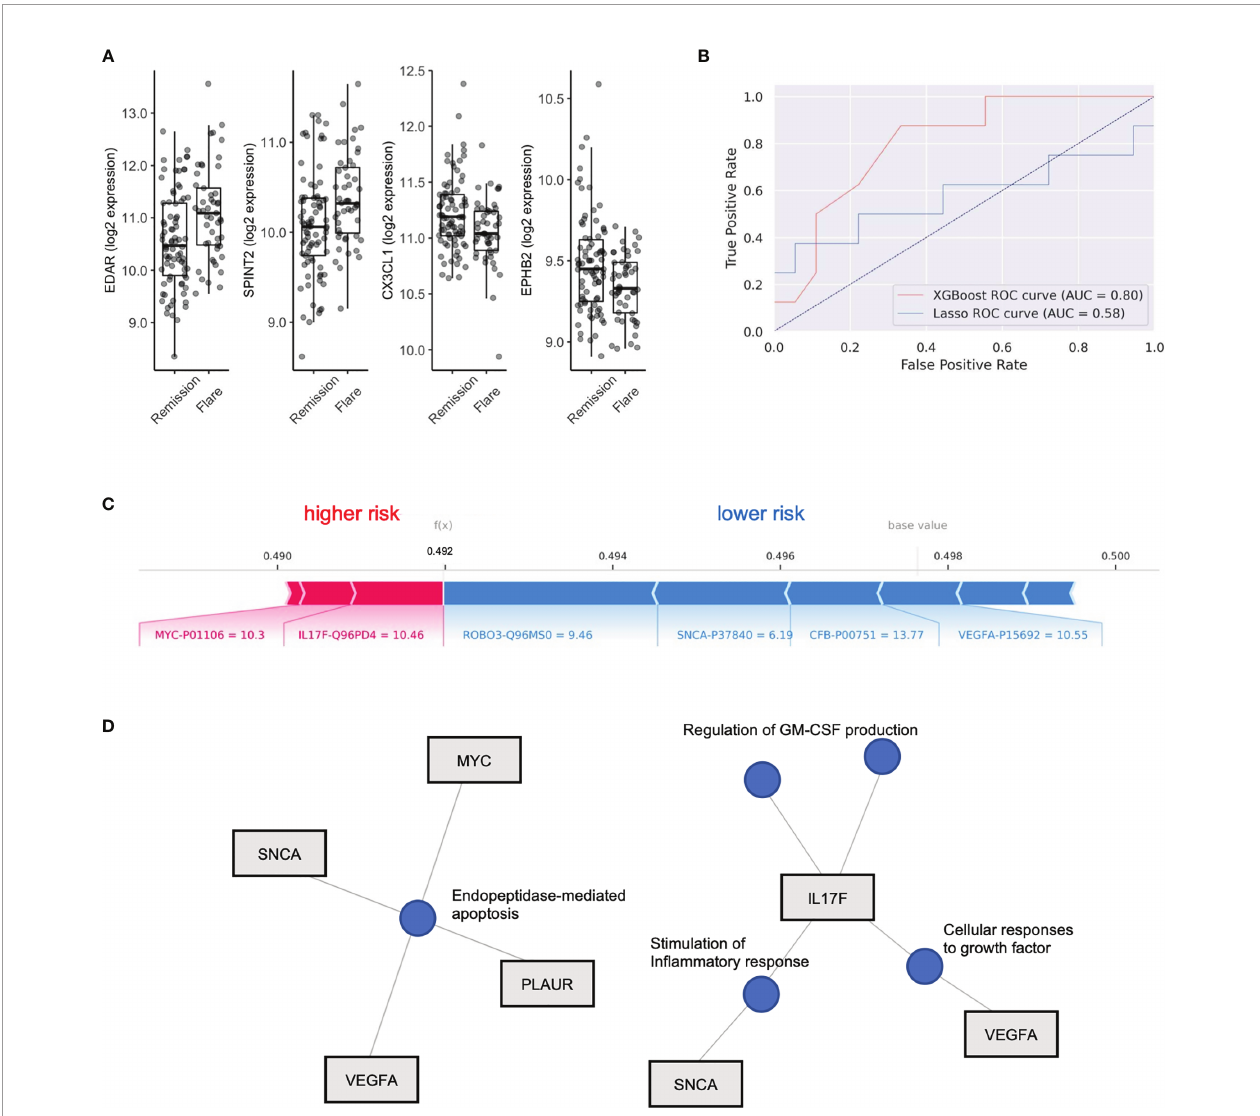
FIGURE 2 | XGboost machine learning to identify fl are or remission in stable RA patients. (A) Box plots of EDAR, SPINT2, CX3CL1 and EPHB2 split by individuals who remained in Remission or Flare. (B) Receiver operator curves (ROC) of 2 machine learning models, XGboost and LASSO, trained on serum proteome to classify fl are or remission. AUC is representative of test set cohort parameters. (C) Bar plot of model features that impact risk of fl are or remission in the XGboost model with log2 expression and Uniprot ID annotated for each protein member. Feature importance is represented by relative size of bar. Values for different proteins represent their original values in the dataset for that particular sample. The base value means the average of the prediction scores, and 0.5 is the cutoff threshold to select a Flare status. (D) Gene concept plots derived from XGboost protein features. Each node represents a GO pathway with proteins connected by edges. EDAR, Ectodysplasin A receptor; SPINT2, Serine peptidase inhibitor; CX3CL1, Fractalkine; EPHB2, Ephrin type-B receptor 2. SNCA, Synuclein alpha; PLAUR, Plasminogen Activator; VEGFA, vascular endothelial growth factor A; MYC, Myc proto-oncogene protein; IL17F, Interleukin 17F; ROBO3, Roundabout homolog 3; CFB, complement factor